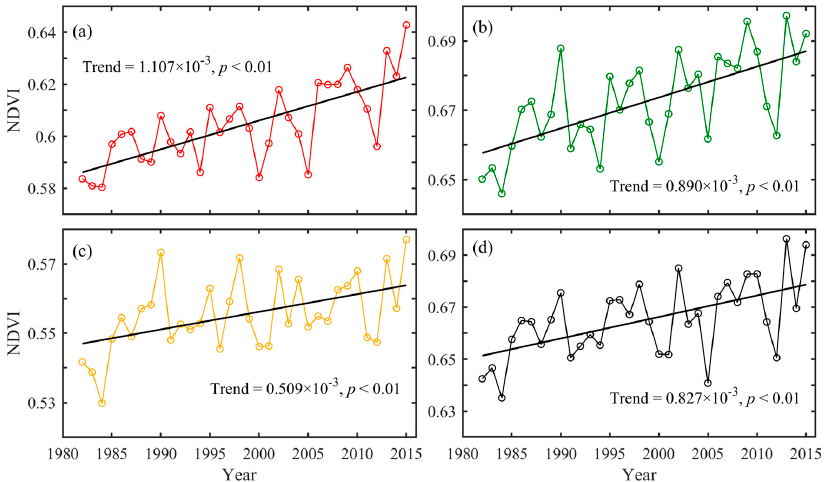
Figure 6. The long-term trend of NDVI of cultivated land ( a ), forest land ( b ), grassland ( c ) and